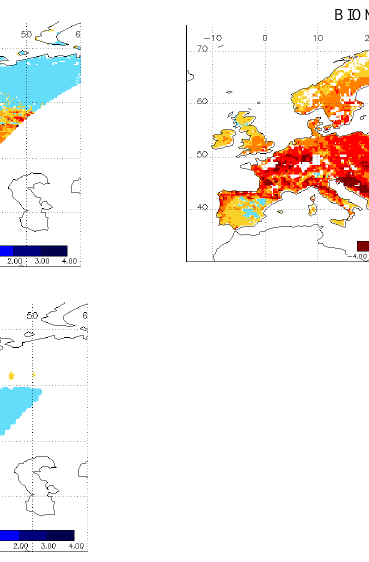
Fig. 6. Cumulative land-atmosphere fluxes (kgC per 50 years, sum over 1951–2000) resulted from land use conversion and rising nitrogen deposition. These fluxes are calculated as difference between NEE from two model experiments Clim+CO 2 +LUC and Clim+CO 2 for ORCHIDEE and JULES and as difference between Clim+CO 2 +N and Clim+CO 2 for BIOME-BGC. Areas colored in different shades of red are carbon sink; areas colored in different shades of blue are carbon